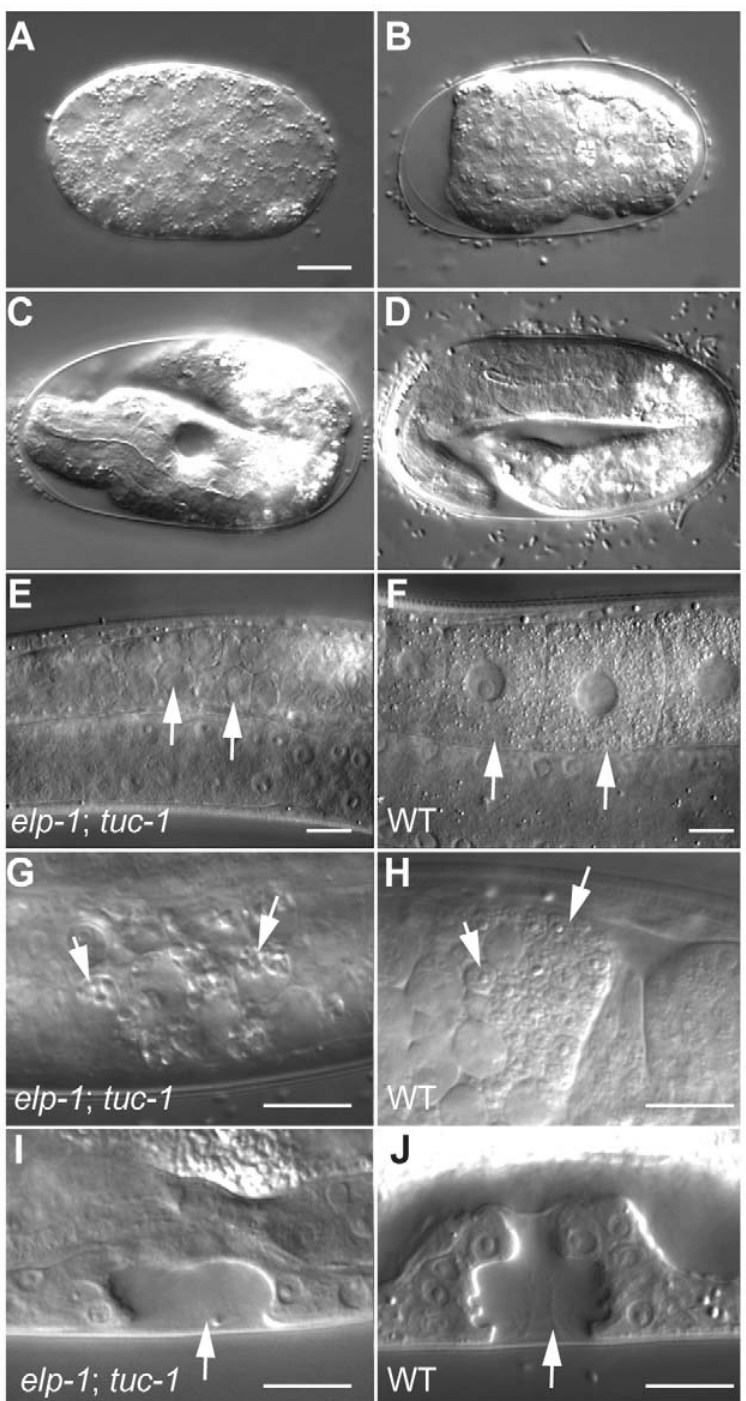
Figure 7. Defects seen in temperature-shifted elpc-1 ; tuc-1 double mutants. Micrographs of eggs and larvae viewed with Nomarski DIC optics. (A–D) Embryos arrested prior to (A), during (B,C) or after (D) morphogenesis. (E,F,G,H) Parts of the germline in young adult hermaphrodites. The arrows in E and F indicate oocytes. Note that those in the elpc-1 ; tuc-1 worm have not matured. The arrows in G and H denote sperm. Those in the elpc-1 ; tuc-1 worm have grossly abnormal morphology. (I,J) The vulva during the L4 stage. In the elpc-1 ; tuc-1 double mutant, fewer cells are present and morphogenesis of the vulva to form the tube through which the eggs are laid is abnormal. Scale bars denote 10 microns.